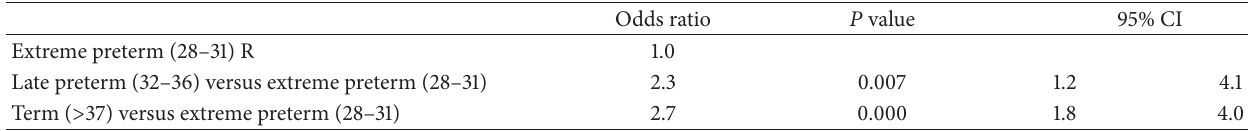
Table 5: Gestation age and cervicovaginal cultures of mothers with